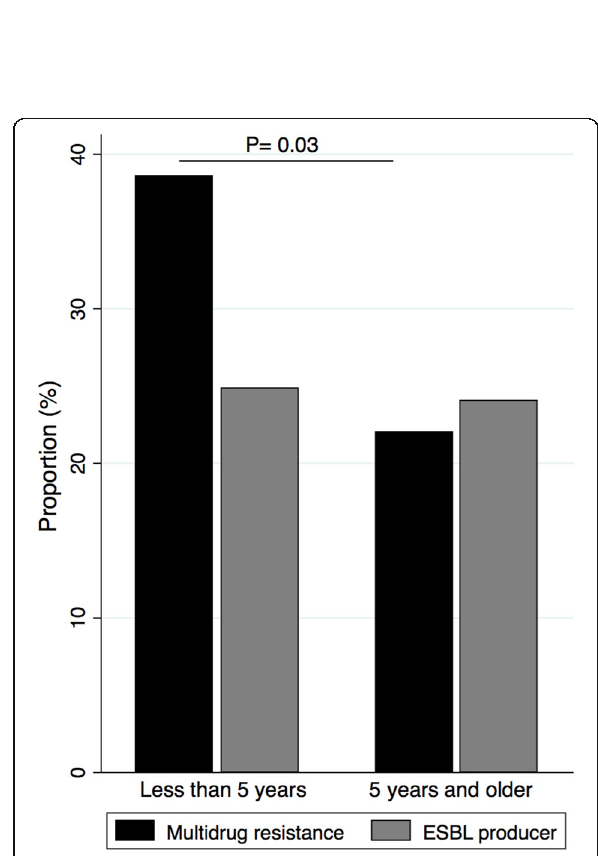
Fig. 3 Distributions of MDR and ESBL-producing uropathogens in children. The bar graph shows the comparison of the proportions of MDR and ESBL-producing uropathogens between children < 5 years old and ≥ 5 years old. The proportions of MDR were 38.6% ( n = 59/ 153) in < 5 years and 22% ( n = 11/50) in ≥ 5 years old children ( P = 0.03)